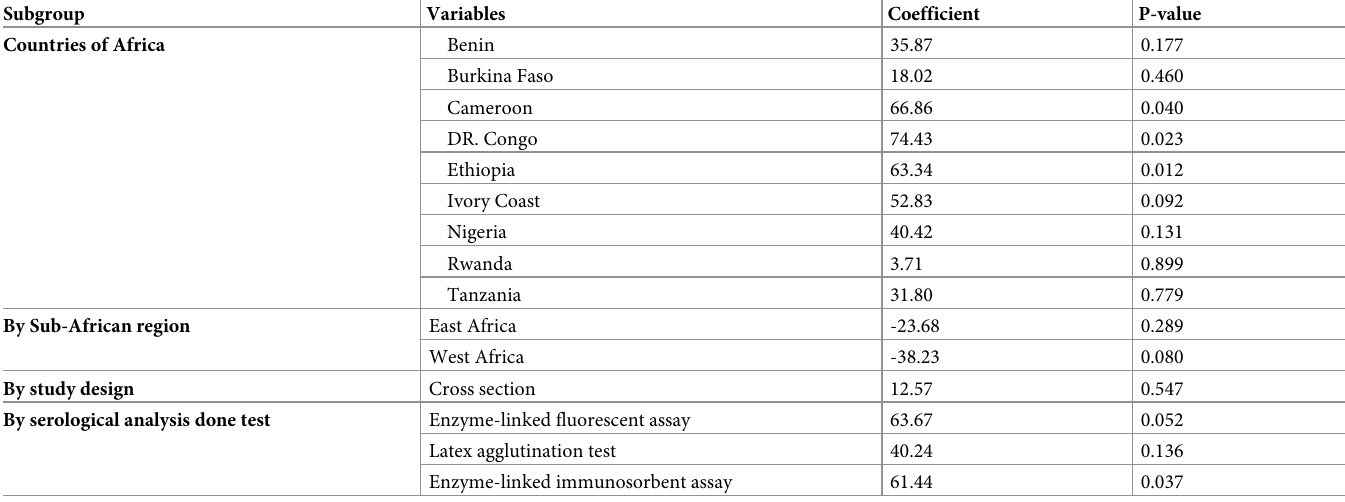
Table 3. Meta-regression analysis of the different study-level sources of heterogeneity for meta-analysis of the prevalence of toxoplasmosis among pregnant women in